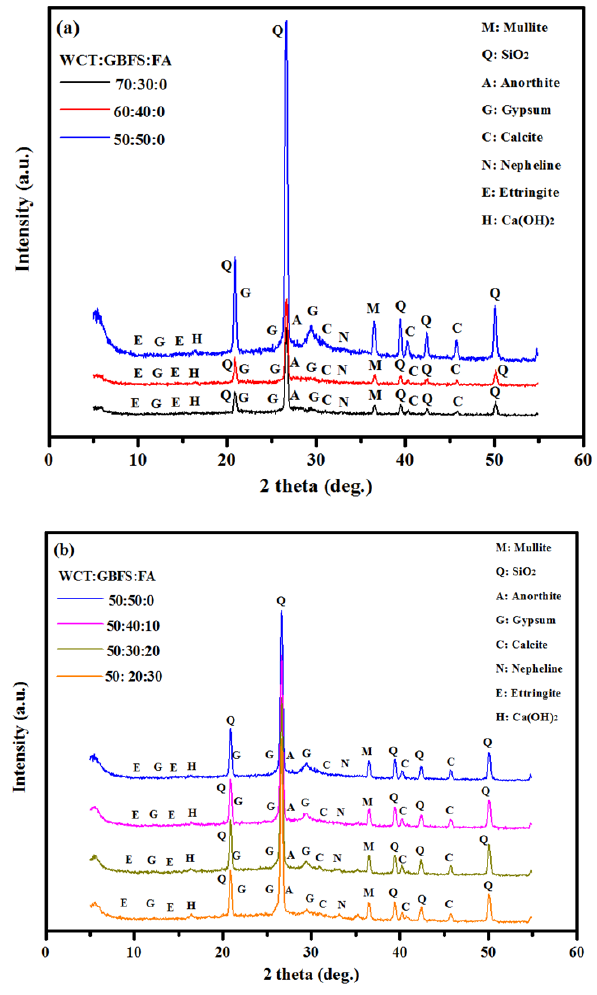
Figure 7. XRD patterns of GPMs exposed to sulfuric acid for 365 days ( a ) effect of various WCT levels and ( b ) effects of various FA levels.